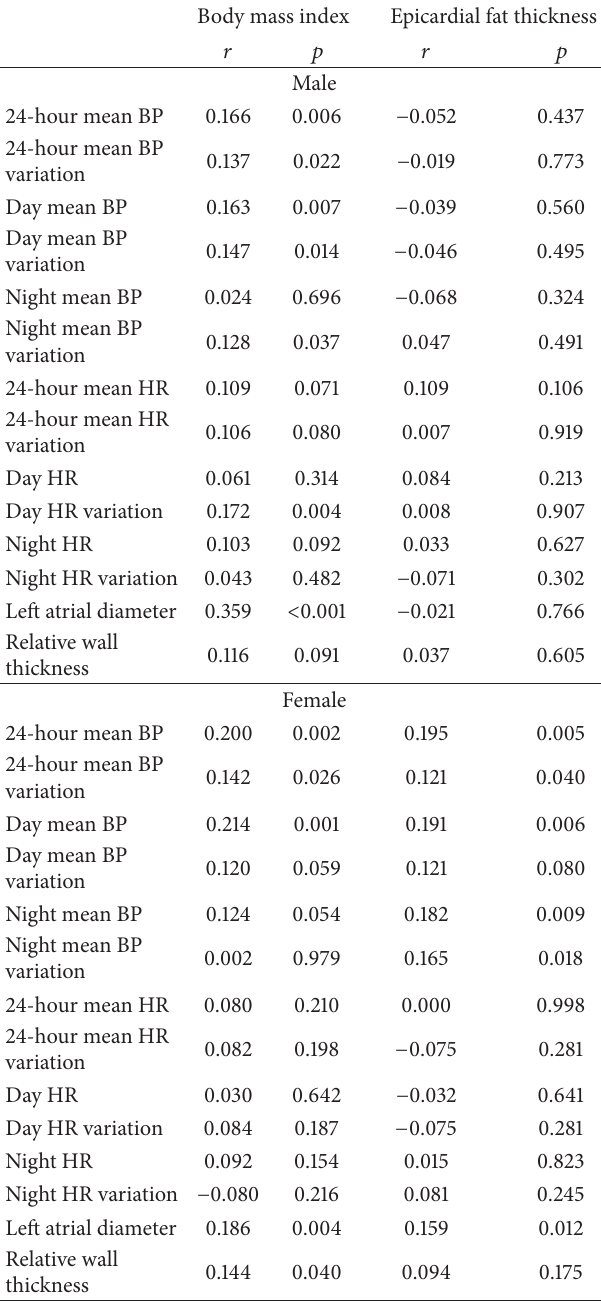
Table 6: Correlation between body mass index or epicardial fat thickness and 24-hour ambulatory blood pressure